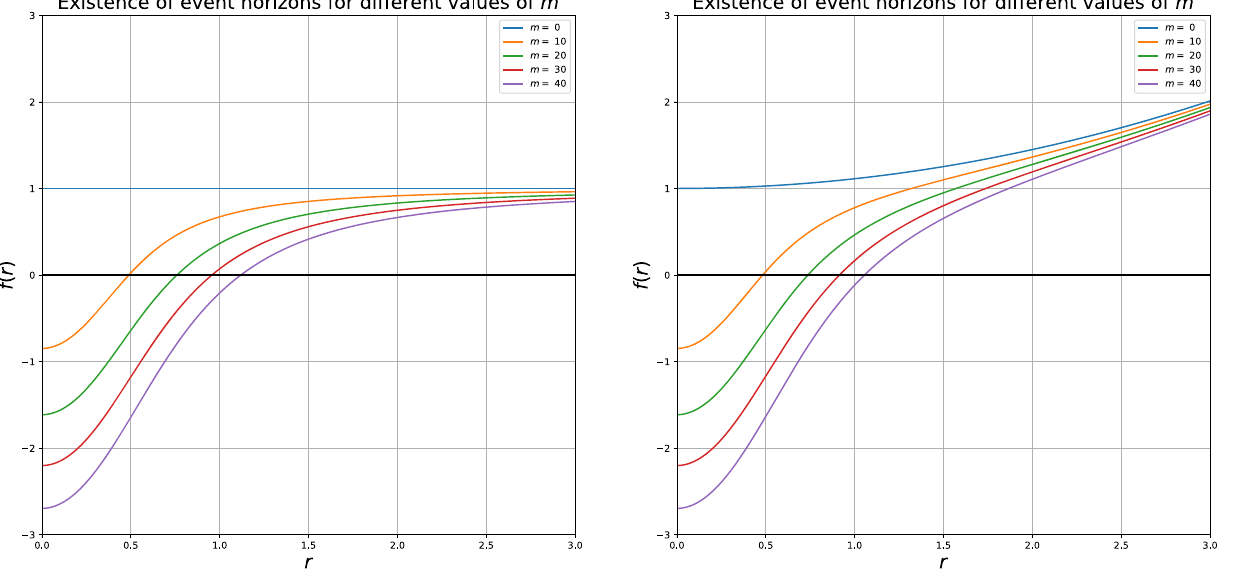
Fig. 1 Hereweplotthemetricfunction f ( r ) comingfromtheeffective Wheeler’s polynomial, for different values of the integration constant m . The black holes in the left panel lead to asymptotically flat black strings in Einstein–Gauss–Bonnet theory in six dimensions, while the